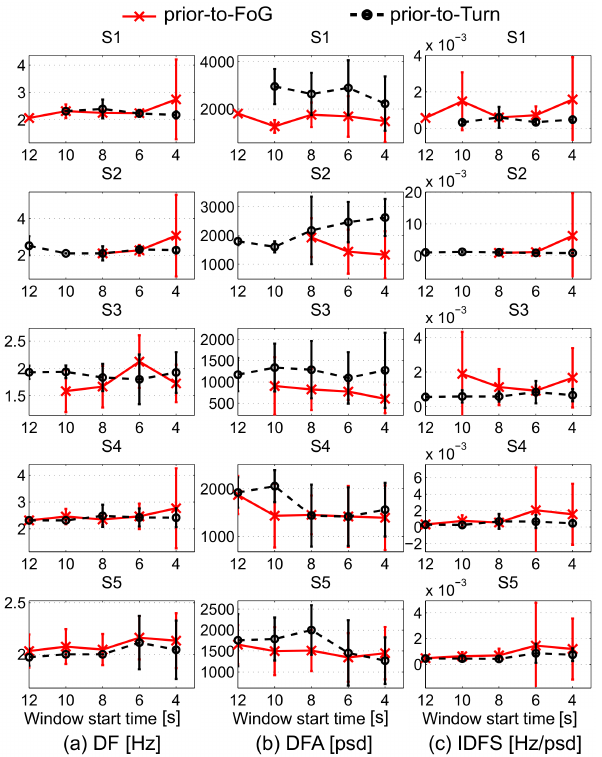
Figure 7: The average and standard deviation across all 5 subjects, for the three frequency features in case of prior-to-FoG and prior-to-turn . The time axis follows the same convention as in Figure 5.